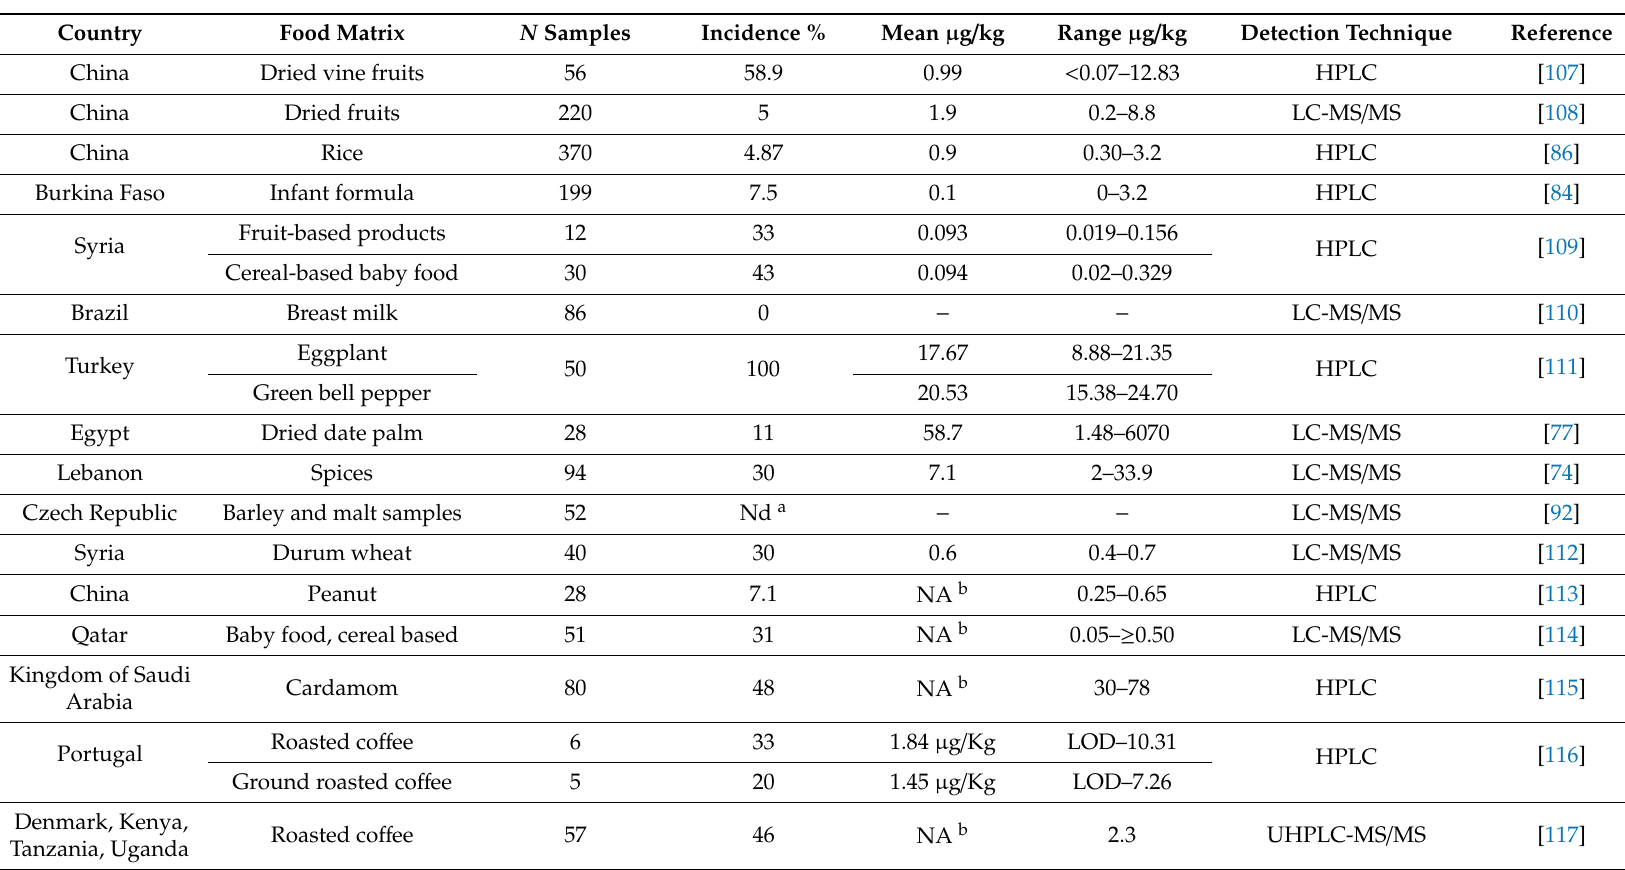
Table 5. Representative studies on the occurrence of ochratoxin A (OTA) distribution ( µ g / kg or µ g / L) in food samples around the world during 2014–2019. Country Food Matrix N Samples Detection Technique